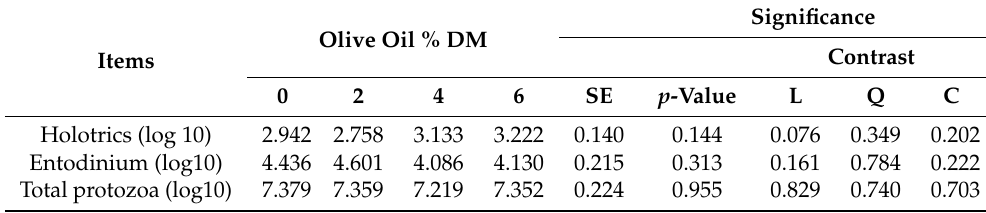
Table 5. Protozoa population (log10 cells/mL) of growing lambs fed with different levels of olive oil.